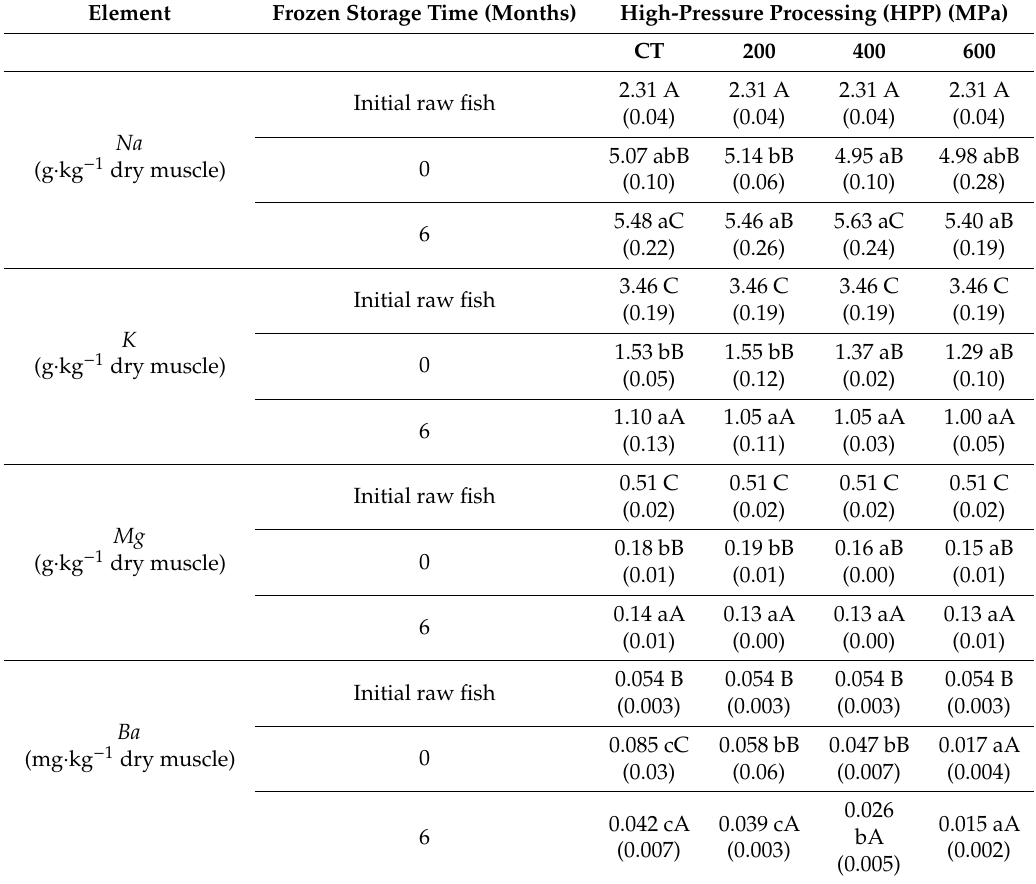
Table 2. Determination of di ff erent alkali ( Na and K ) and alkaline earth ( Mg and Ba ) metal elements contents * in initial raw fish and canned mackerel subjected to di ff erent processing conditions